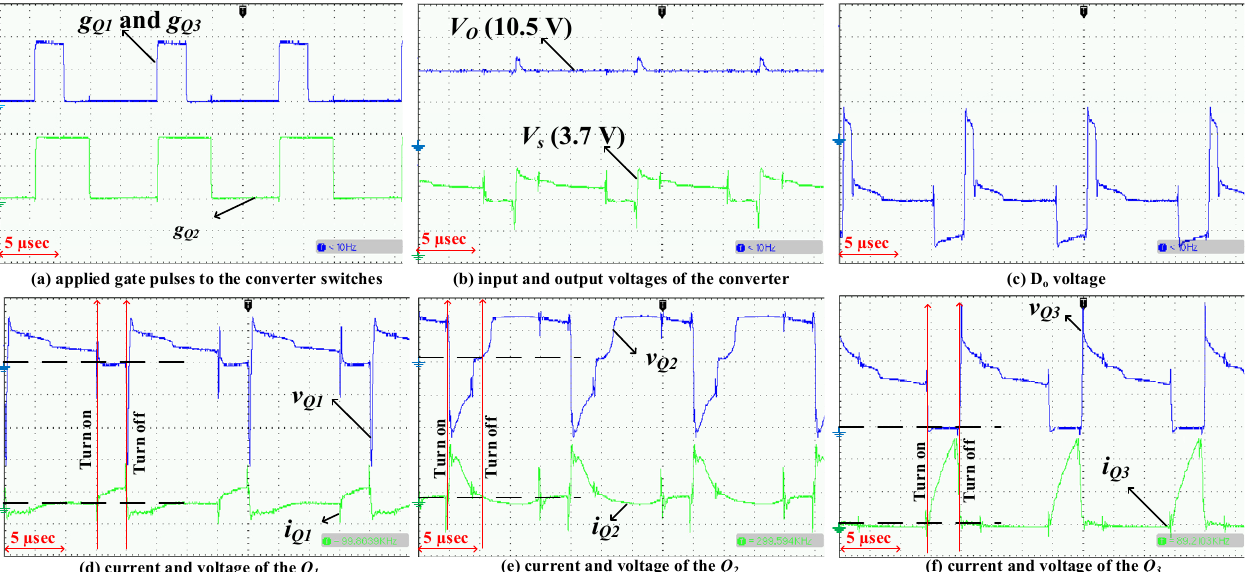
Figure 12. Experimental validation of the proposed converter gain and soft switching. The time division of all presented images in this figure is 2.5 μ s. ( a ) Control signals (2 V/div); ( b ) output voltage (5 V/div), input voltage (2 V/div); ( c ) diode voltage (5 V/div); ( d ) Q1 voltage (5 V/div), Q1 current (1.66 A/div); ( e ) Q2 voltage (2 V/div), Q2 current (0.66 A/div); ( f ) Q3 voltage (2 V/div), Q3 current (0.66 A/div).